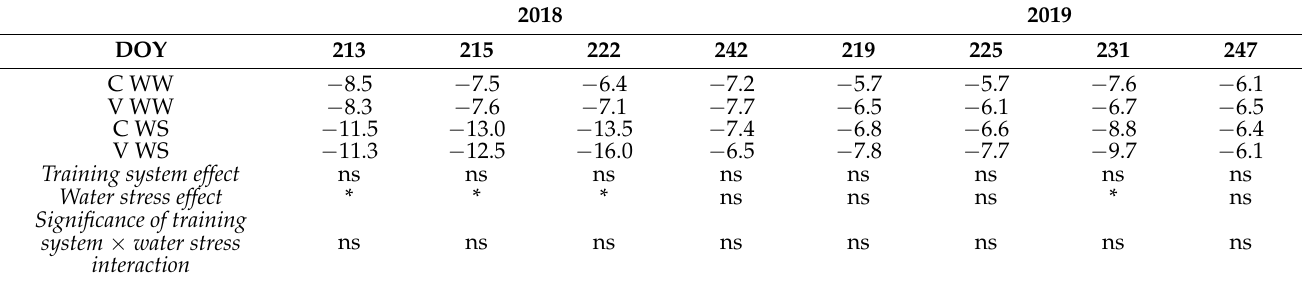
Figure 2. Seasonal pattern of daily lysimeter transpiration in water-stress (WS) and well-watered (WW) vines during the stress period in the 2018 ( A ) and 2019 ( B ) seasons. Data are average of 8 vines ± SE. Within each day, an asterisk indicates a significant difference between the two water regimes as calculated by the Tukey test ( p ≤ 0.05). Table 2. Stem water potential ( Ψ stem , bar) of Sangiovese vines subjected to both a different training system and water restriction during the veraison stage. The re-watering date was DOY 242 and 247 for the 2018 and 2019 season, respectively. Values represent means of 4 replicates: C WW = well-watered vertical shoot-positioned canopy, V WW = well-watered V-shaped open canopy, C WS = vertical shoot-positioned canopy with water restriction, V WS = V-shaped open canopy with water restriction. Significant differences are indicated: *, p < 0.05; ns, not significant. Mean values were separated within each column with different letters using the Tukey test.